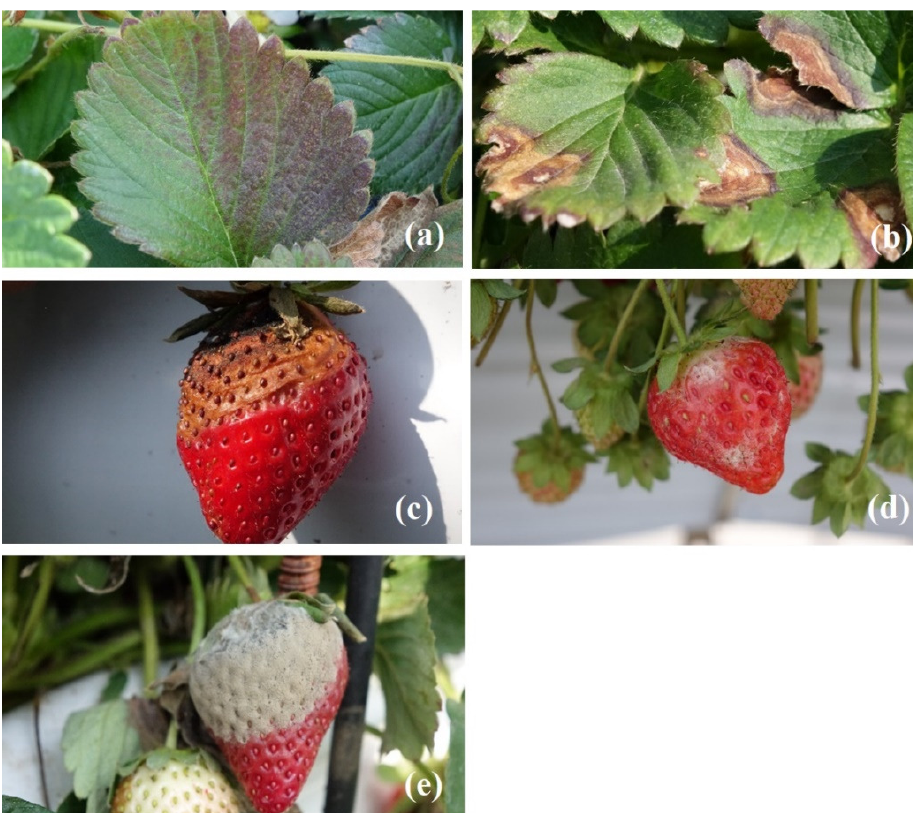
Figure 4. A total of 792 original images for different diseases of strawberry plant— ( a ) crown rot caused by leaf blight, ( b ) leaf blight, ( c ) fruit rot caused by leaf blight, ( d ) powdery mildew, and ( e ) gray mold.